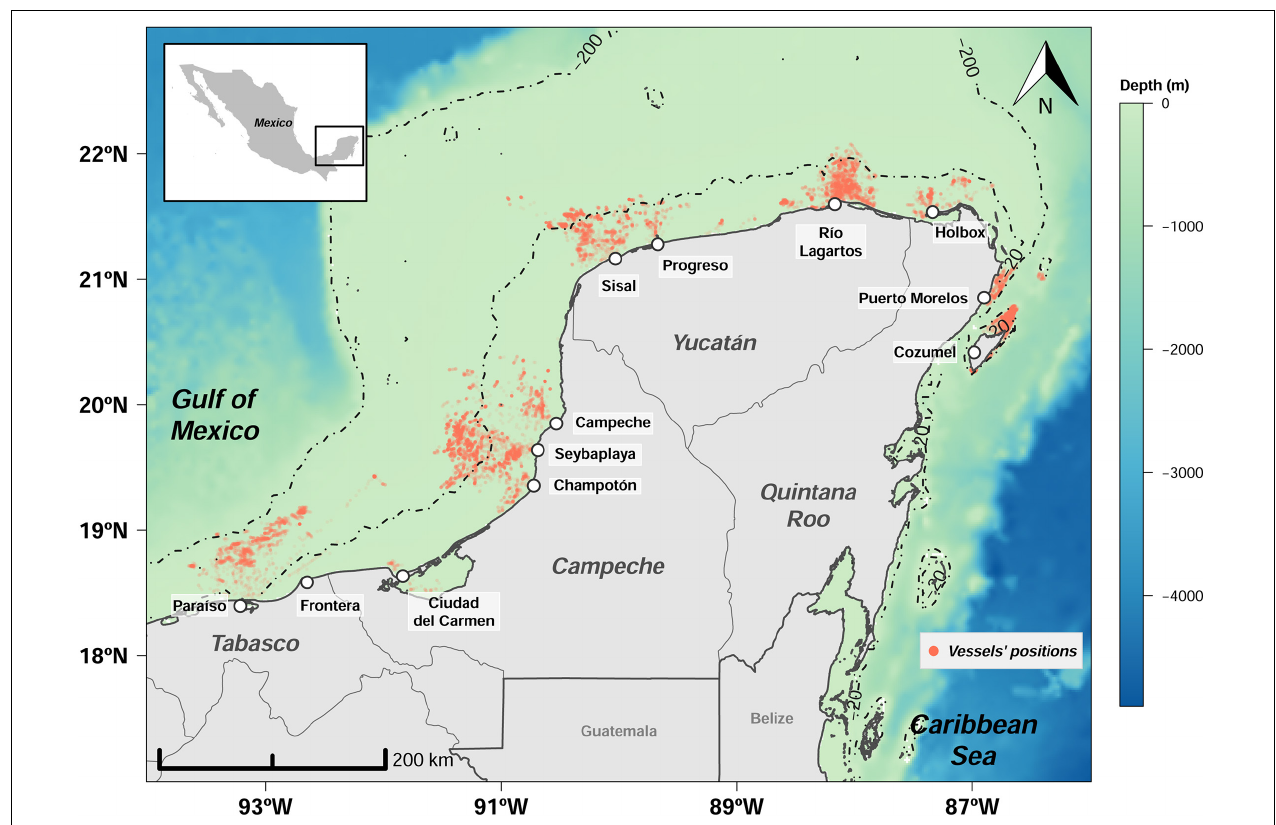
FIGURE 1 | Fishing communities in Southeastern Gulf of Mexico where the study was undertaken. Orange dots represent the geographical coordinates acquired from the pilot vessel monitoring